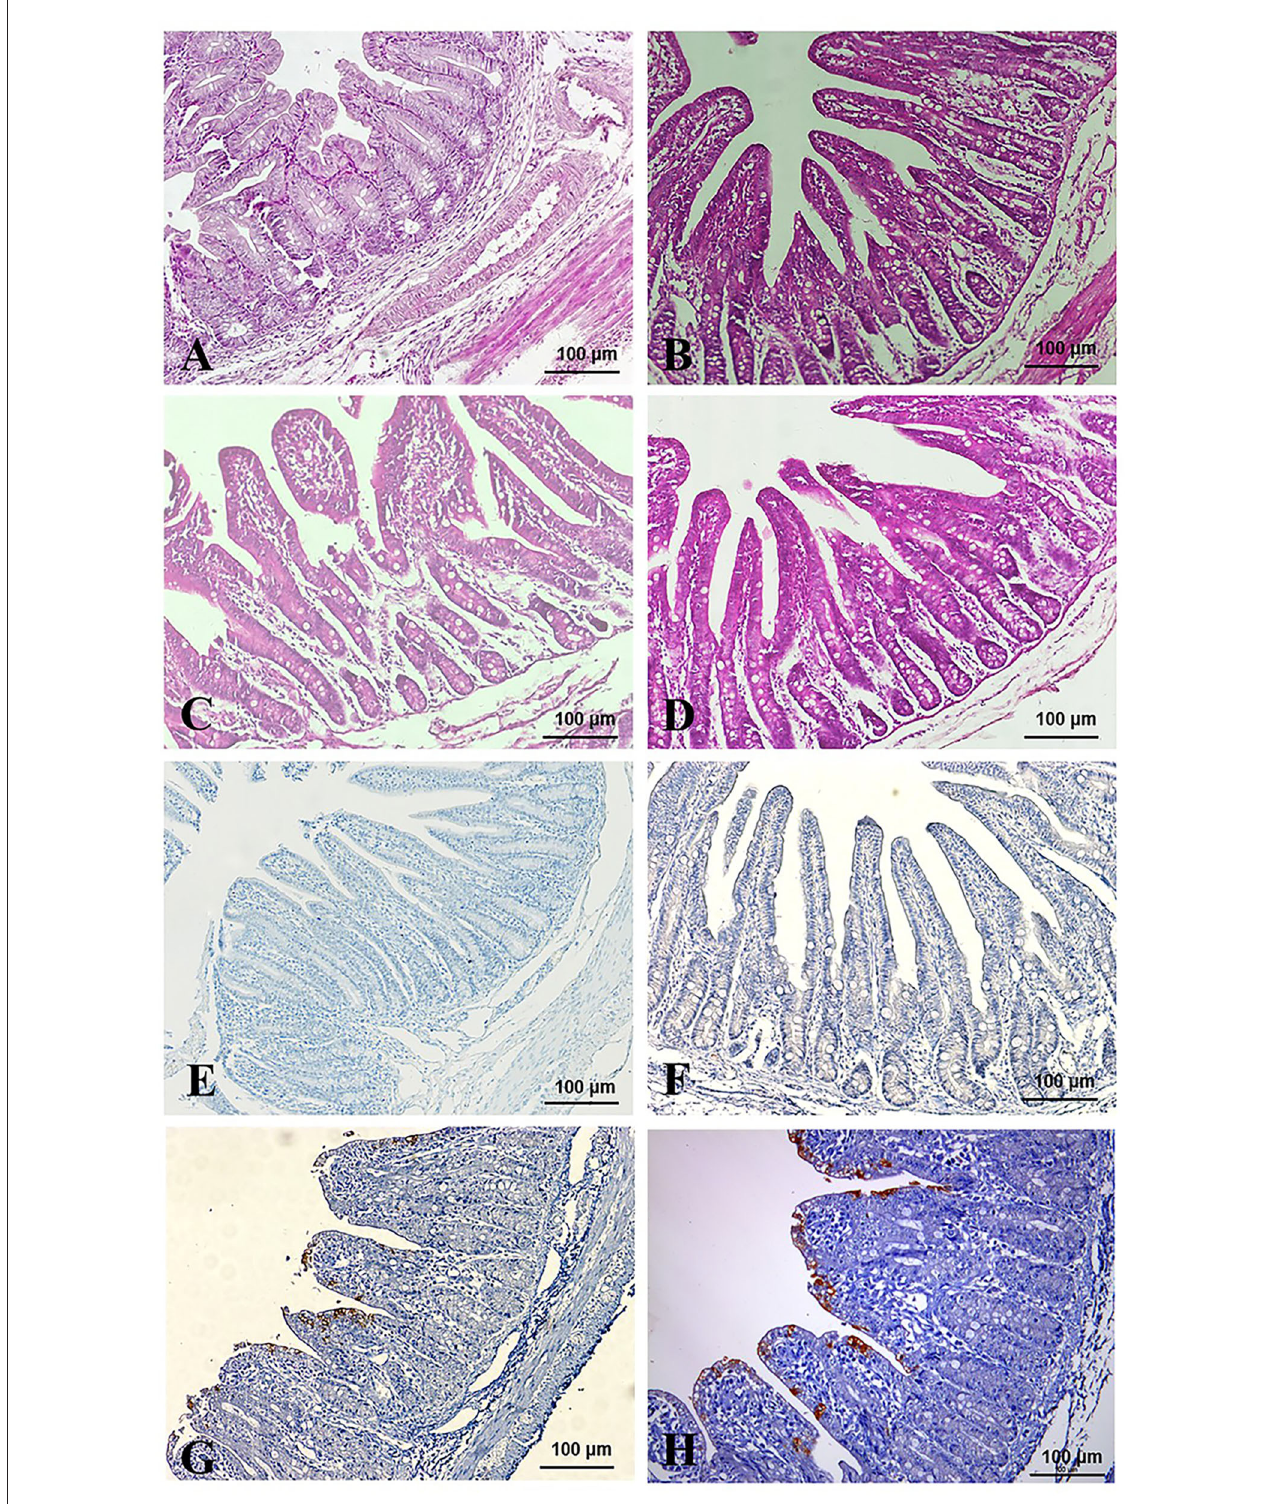
FIGURE 6 | Pathological changes and IHC assays of TGEV HQ2016-inoculated piglets. (A,B) H.E staining for jejunum and ileum tissue section of control piglets. (C,D) H.E staining for jejunum and ileum tissue section of TGEV HQ2016 challenged piglets. Villus atrophy, degenerate mucosal epithelial cells, and necrosis. (E,F) IHC assays for jejunum and ileum tissue section of control piglets. (G,H) IHC assays for jejunum and ileum tissue section of TGEV HQ2016 challenged piglets. Positive cells presented in the epithelial cells in the atrophied villi of the segments of jejunal and ileal tissues from the piglets.